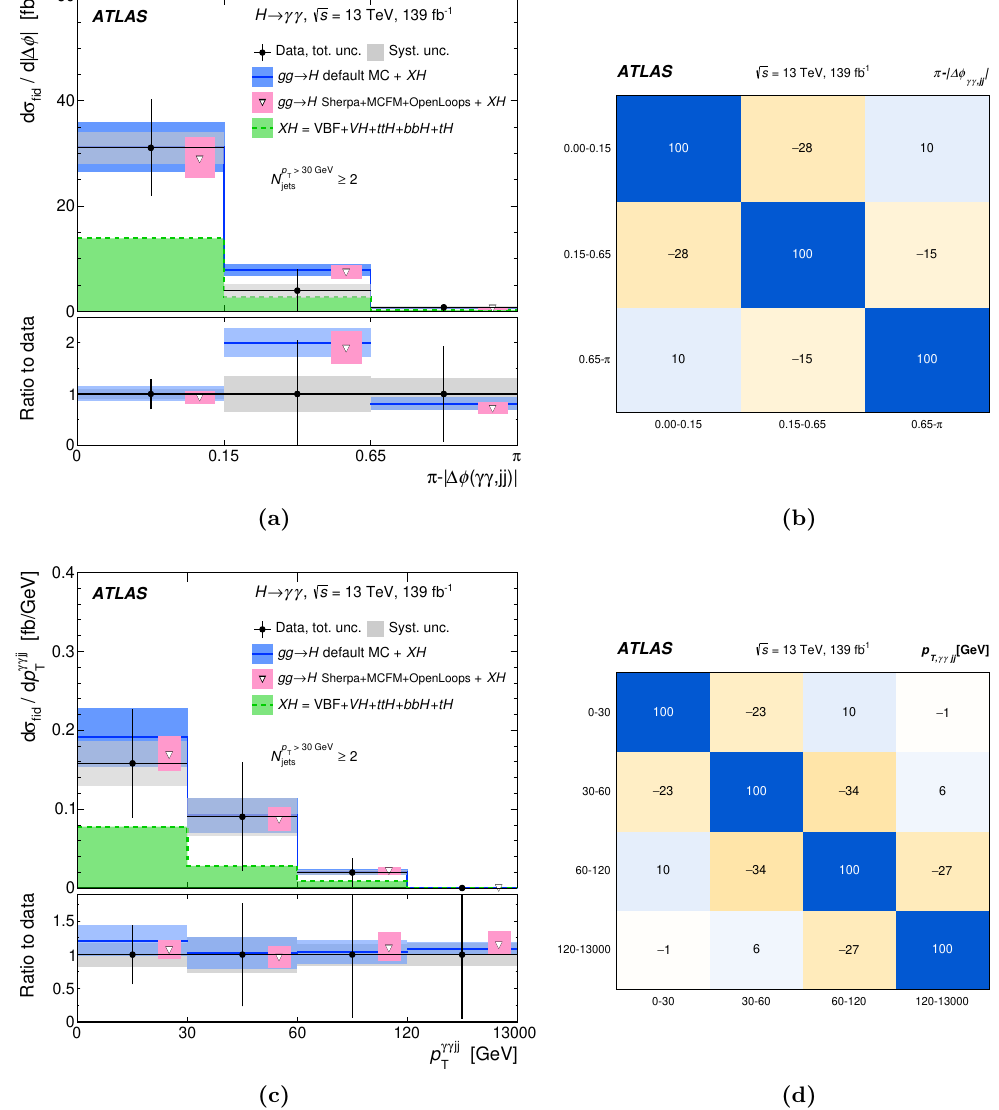
Figure 32. Particle-level fiducial differential cross-sections times branching ratio for the variables (a) π − | ∆ φ and (c) p together with the corresponding correlation matrices ((b) and γγ,jj | T ,γγjj